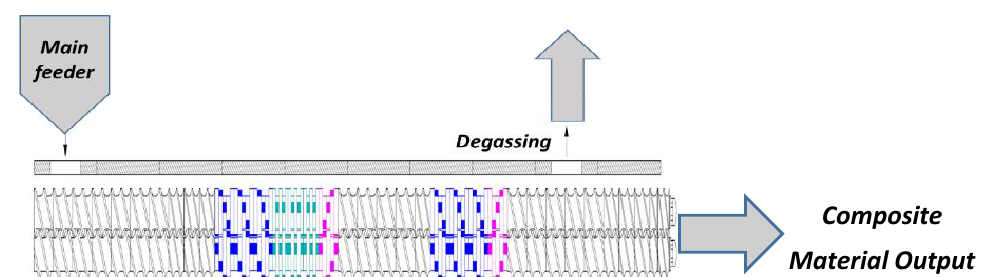
Figure 2. Screw profile scheme used in the present experiment.